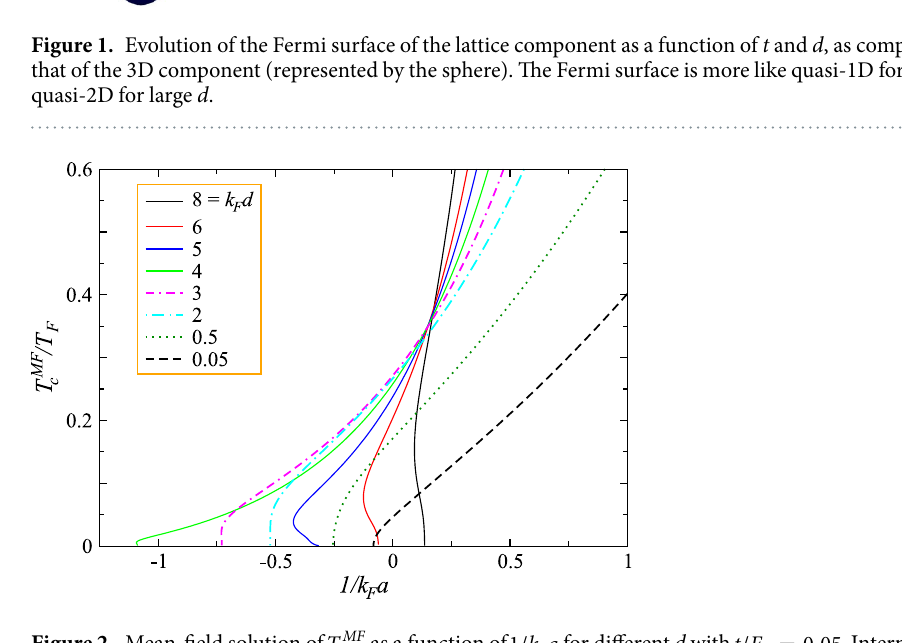
for different d with = . t E / 0 05 . Intermediate F F